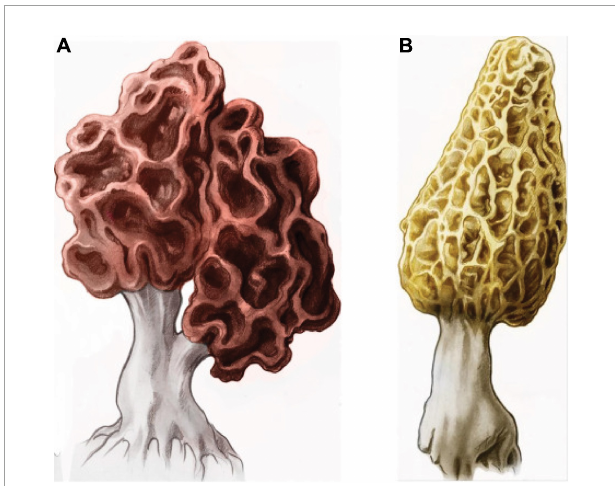
FIGURE2 (A) False Morel ( Gyromitra esculenta ). (B) True Morel ( Morchella esculenta ). Reproduced from Arłukowicz-Grabowska et al.